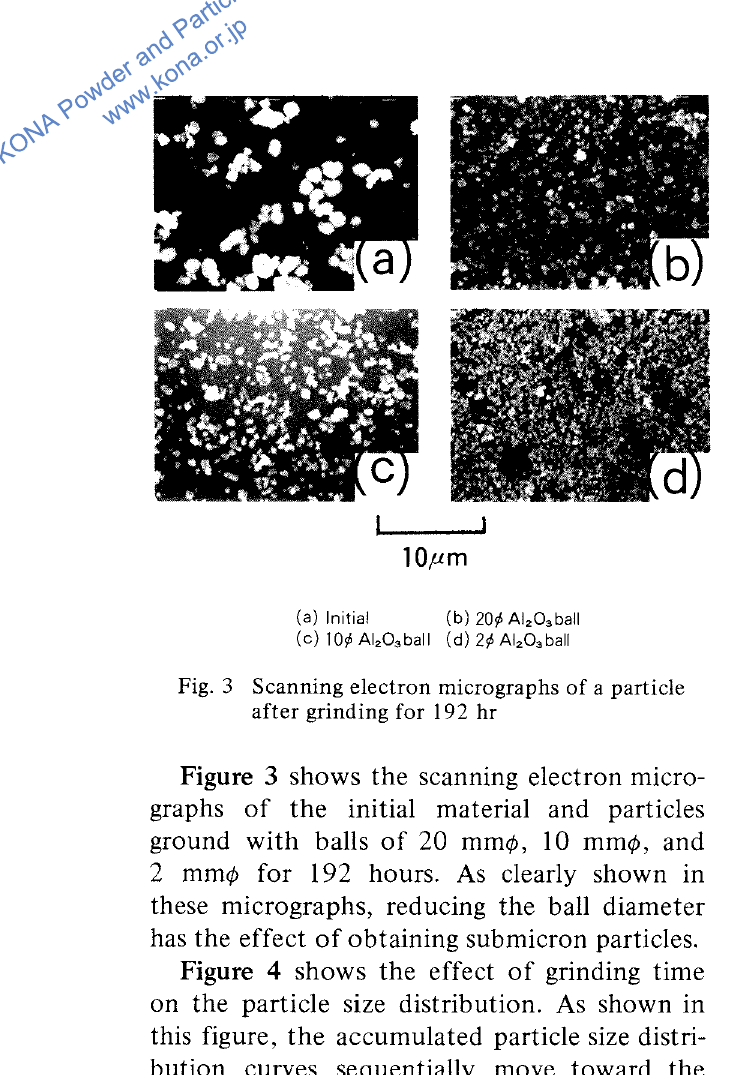
Fig. 3 Scanning electron micrographs of a particle after grinding for 192 hr